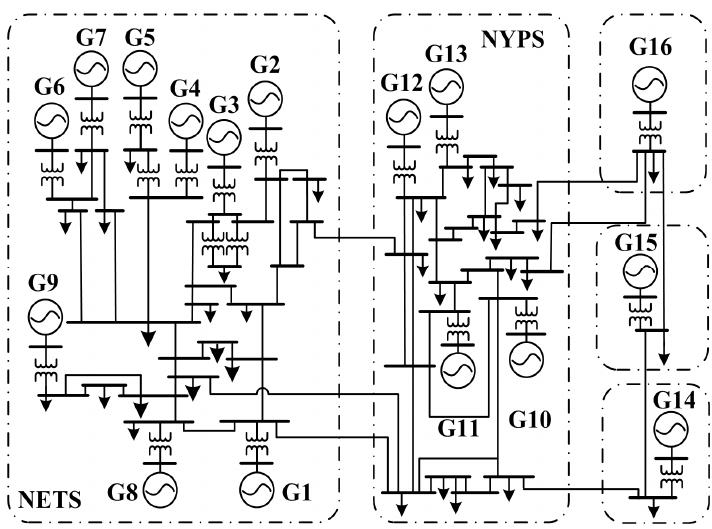
Figure 12. The New England Test System and the New York Power System (NETS and NYPS) test system.